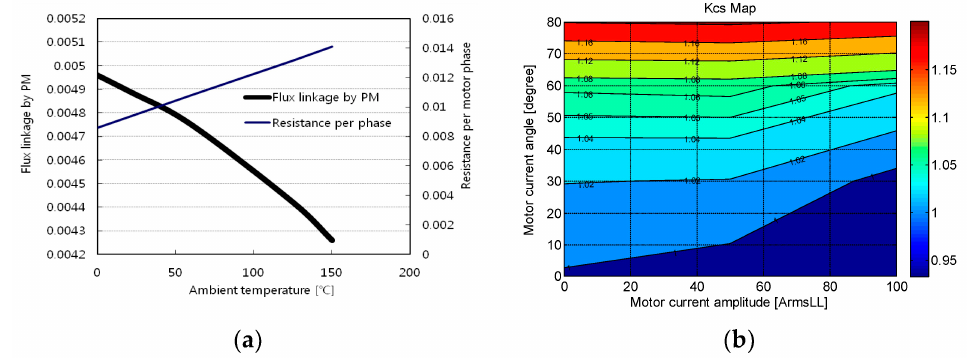
Figure 2. Calculation of Ψ , Rph, and Kcs: ( a ) flux linkage ( Ψ ) by PM and resistance (Rph) per phase; ( b ) map of the saturation coefficient (Kcs) by considering the magnetic saturation effect in the core.